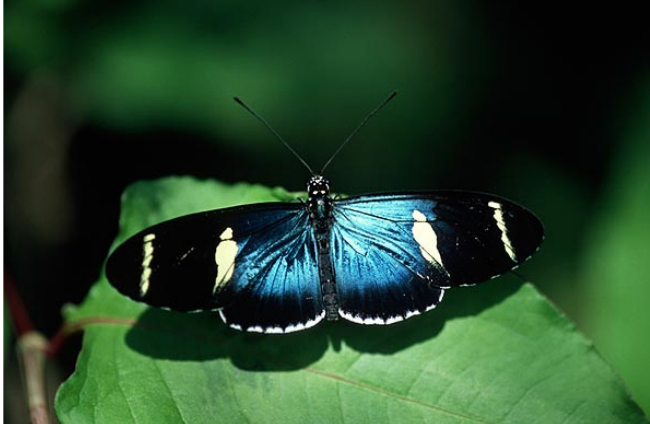
Figure 1 . Heliconius sara